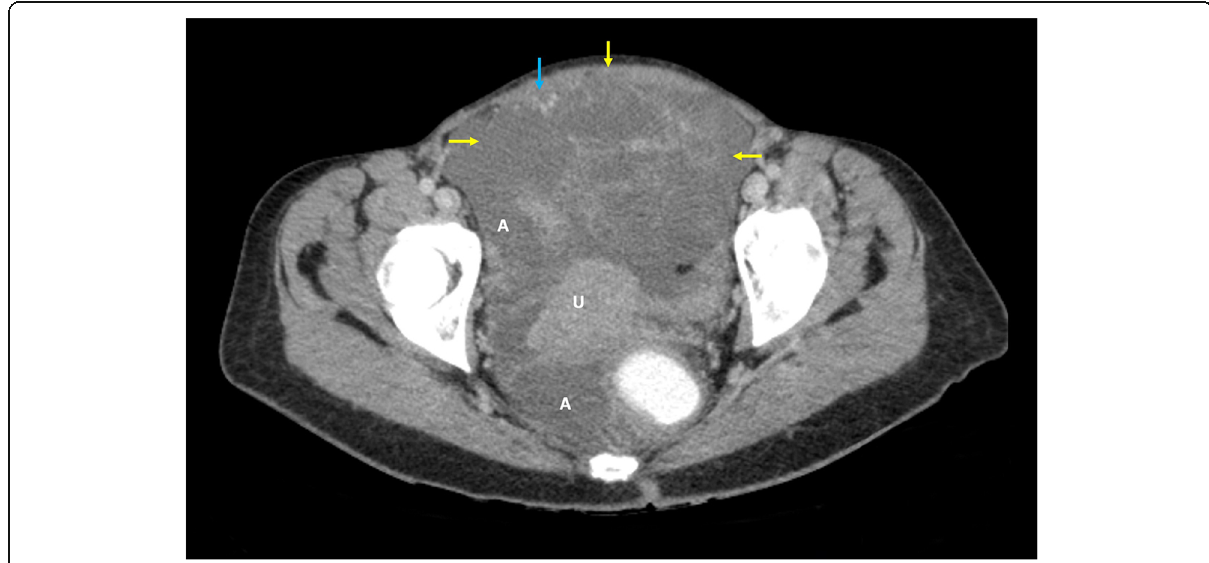
Fig. 5 Axial post-contrast MDCT image at the level of pelvis. Many small vessels are also depicted in the anterior reflection of the pelvic peritoneum (light blue arrow), which may indicate another vascular source from the tumour (yellow arrows). The uterus (U) is well delimitated from the tumour, and some ascitic fluid (A) is also